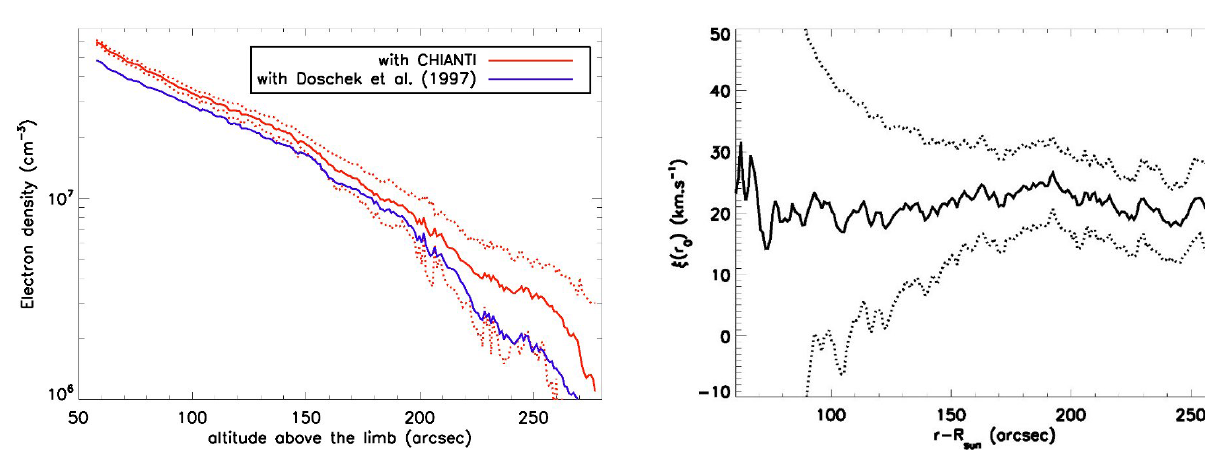
Fig. 1. Electron density with increasing altitude above the polar coronal hole. In red, the new value by using the line ratio computed in the CHIANTI database. In blue, the value previously used in Paper I by using the line ratio data in Doschek et al. (1997). The dotted lines denote the error bars for the new value.